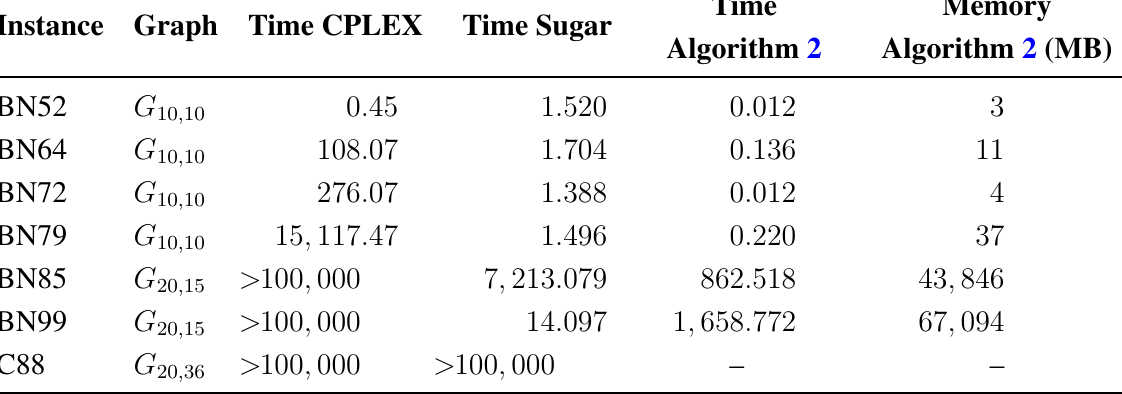
Table 2. Running time in seconds for solving Numberlink with restriction that requires solutions to cover all vertices.